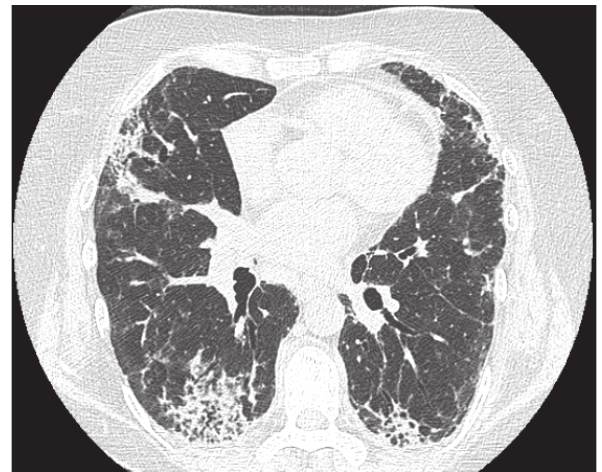
Fig. 1. Dermatomyositis: CT scan of peribronchial fibrosis (white "glass"